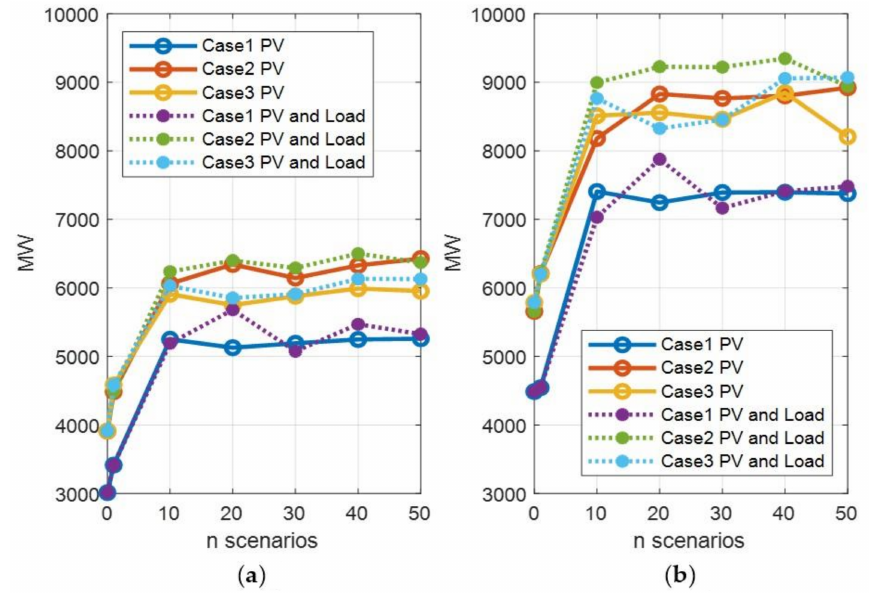
Figure 7. Total ( a ) feasible reserve and ( b ) conventional reserve for every increase in scenarios for cases 1, 2, and